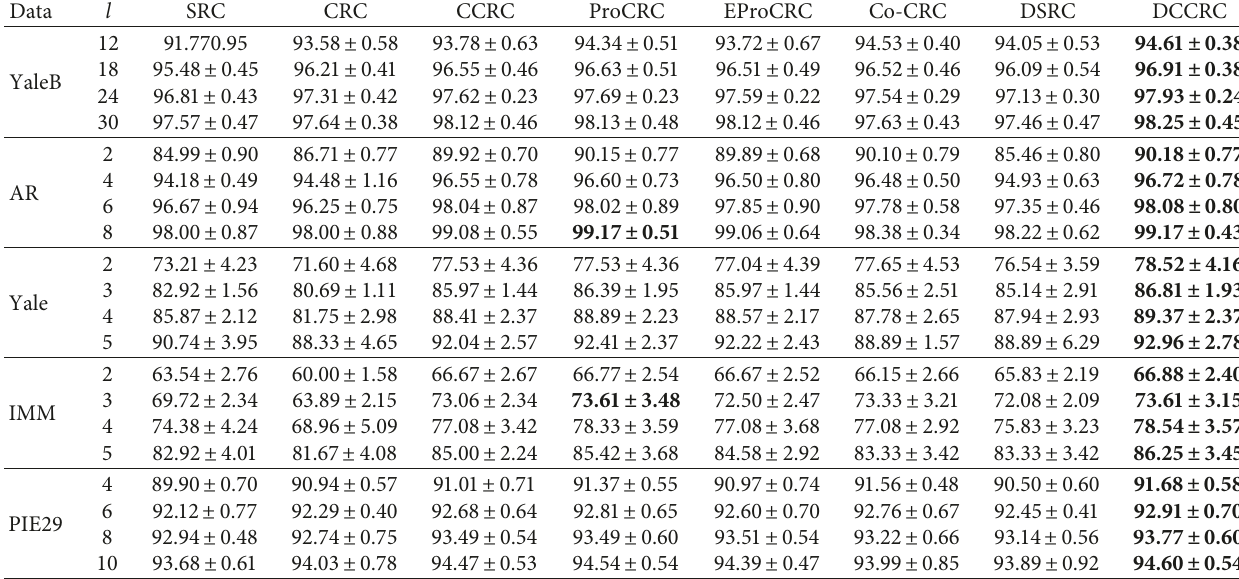
Table 3: The classification accuracies (%) of the competing methods with the corresponding standard deviations with different class-specific training samples on each face database.